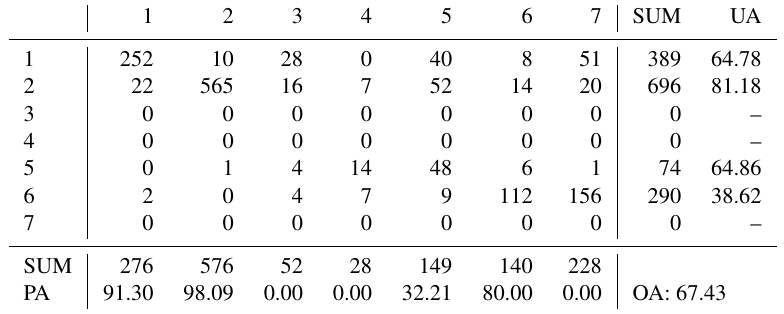
Table B10. Confusion matrix for LANDMATE PFT group 1.0 – the dominant LULC type occupies 100% of a LANDMATE PFT grid